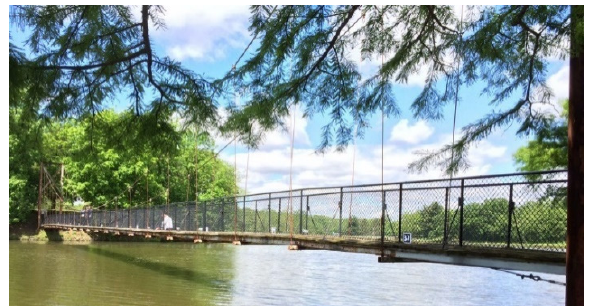
Figure 9. Suspension bridge in Lake of the Woods, Mahomet, IL, USA.